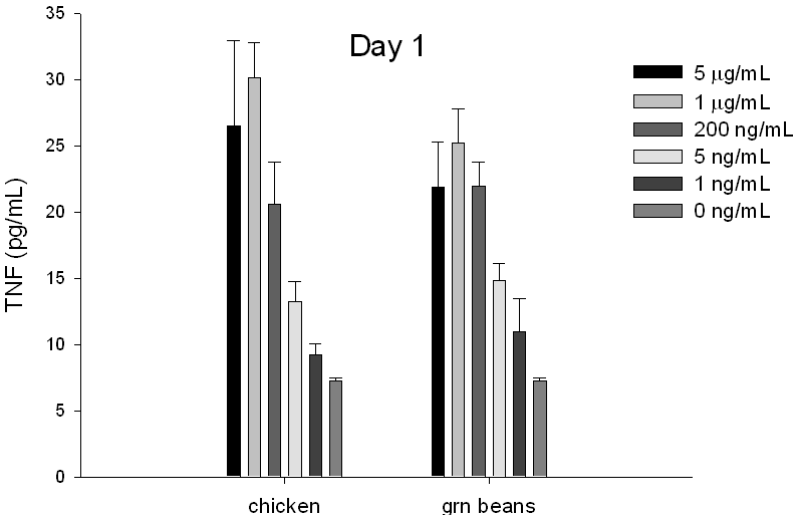
Figure 4. Quantification of biologically active SEA in food using ELISA assay. Chicken and green beans were spiked with increasing concentrations of SEA. Immunomagnetic beads were used to extract the toxin. Eluted toxin from beads was incubated with splenocytes. TNF secretion was measured by ELISA assay . Error bars represent standard